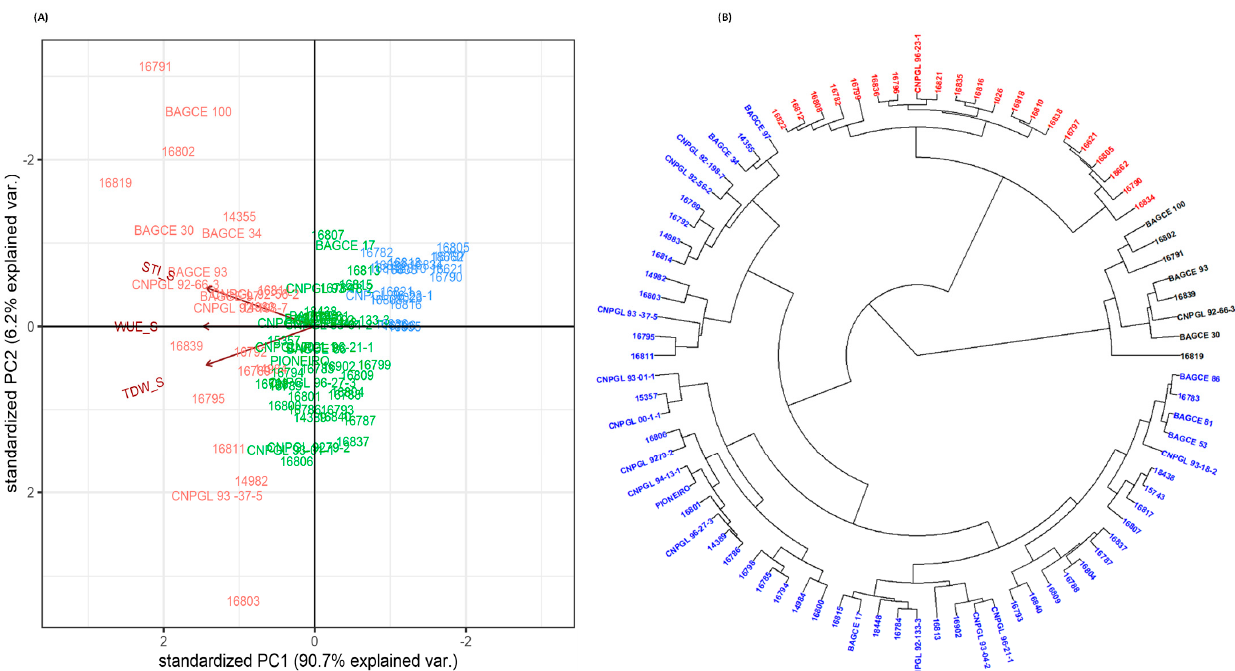
Figure 4. Grouping by drought stress response of Napier grass genotypes, based on STI, WUE and TDW, under moderate water stress using: ( A ) PCA and ( B ) cluster analysis. Both analyses discrim- inate highly tolerant, moderately tolerant and susceptible genotypes. Water use efficiency (WUE), total dry weight (TDW) and stress tolerance index (STI).